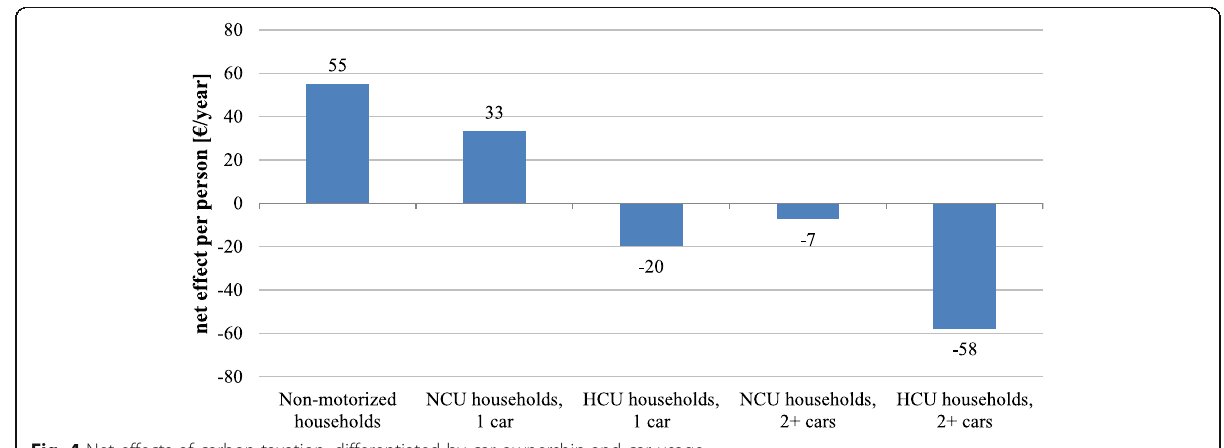
Fig. 4 Net effects of carbon taxation, differentiated by car ownership and car